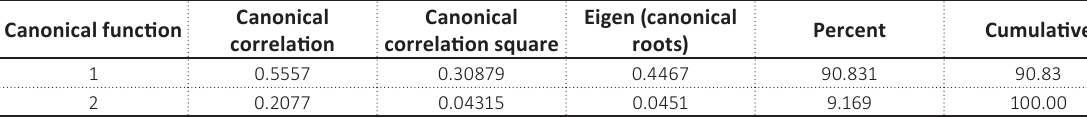
Table 3. The canonical correlation (the financial sector) Canonical function